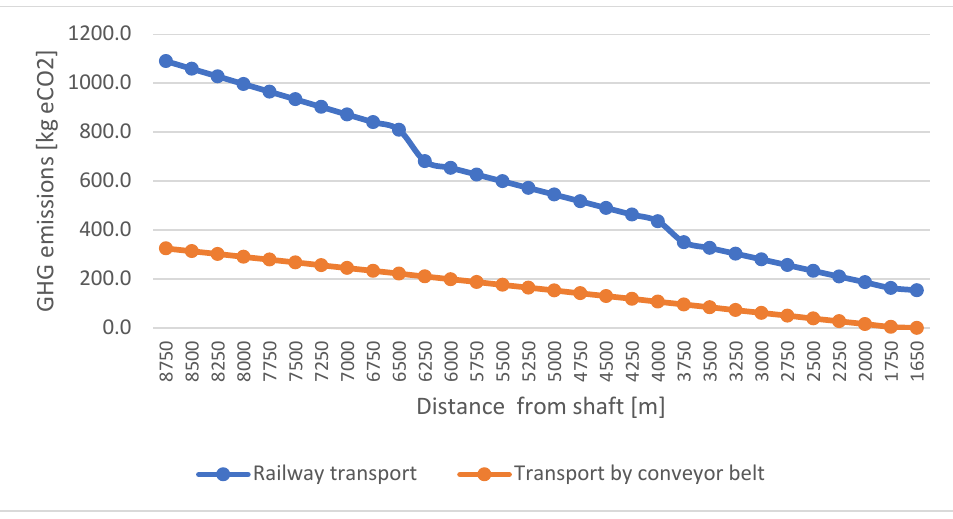
Figure 4. Energy required for the daily crew transport cycle using belt conveyors and suspended railway rolling stock.